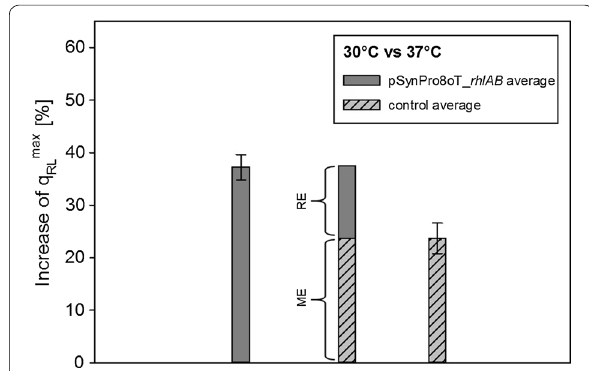
Fig. 5 Comparison of increase in specific rhamnolipid production rate of Pseudomonas putida KT2440 pSynpro8oT_ rhlAB and control plasmid with inactivated RNA-thermometer at 30 °C and 37 °C respectively. Average differences in production rate calculated from individual biological data are shown with derived metabolic effect (ME) and regulatory (RE)